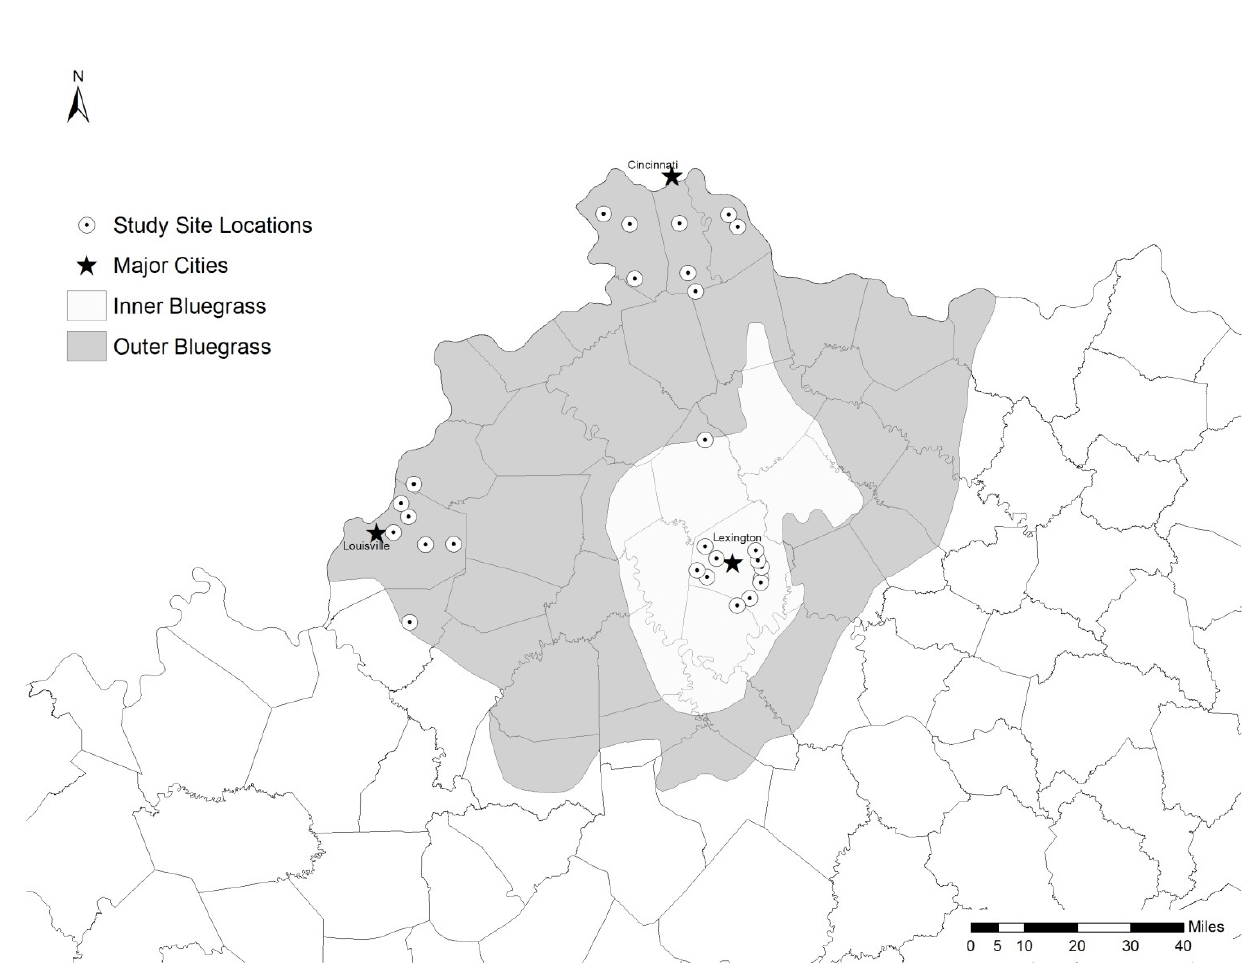
Figure 1. Study site locations (U.S. Geological Survey gages) within the Inner Bluegrass and Outer Bluegrass regions of Kentucky. Adapted from Brockman et al . [42]. Used by permission from